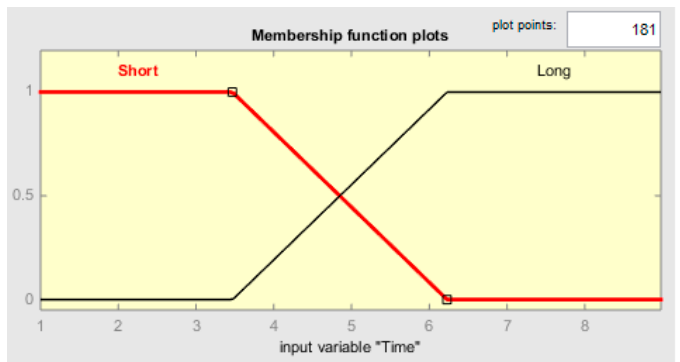
Figure 10. MF plot for CR-Humidity. Figure 11. MF plot for TIME.